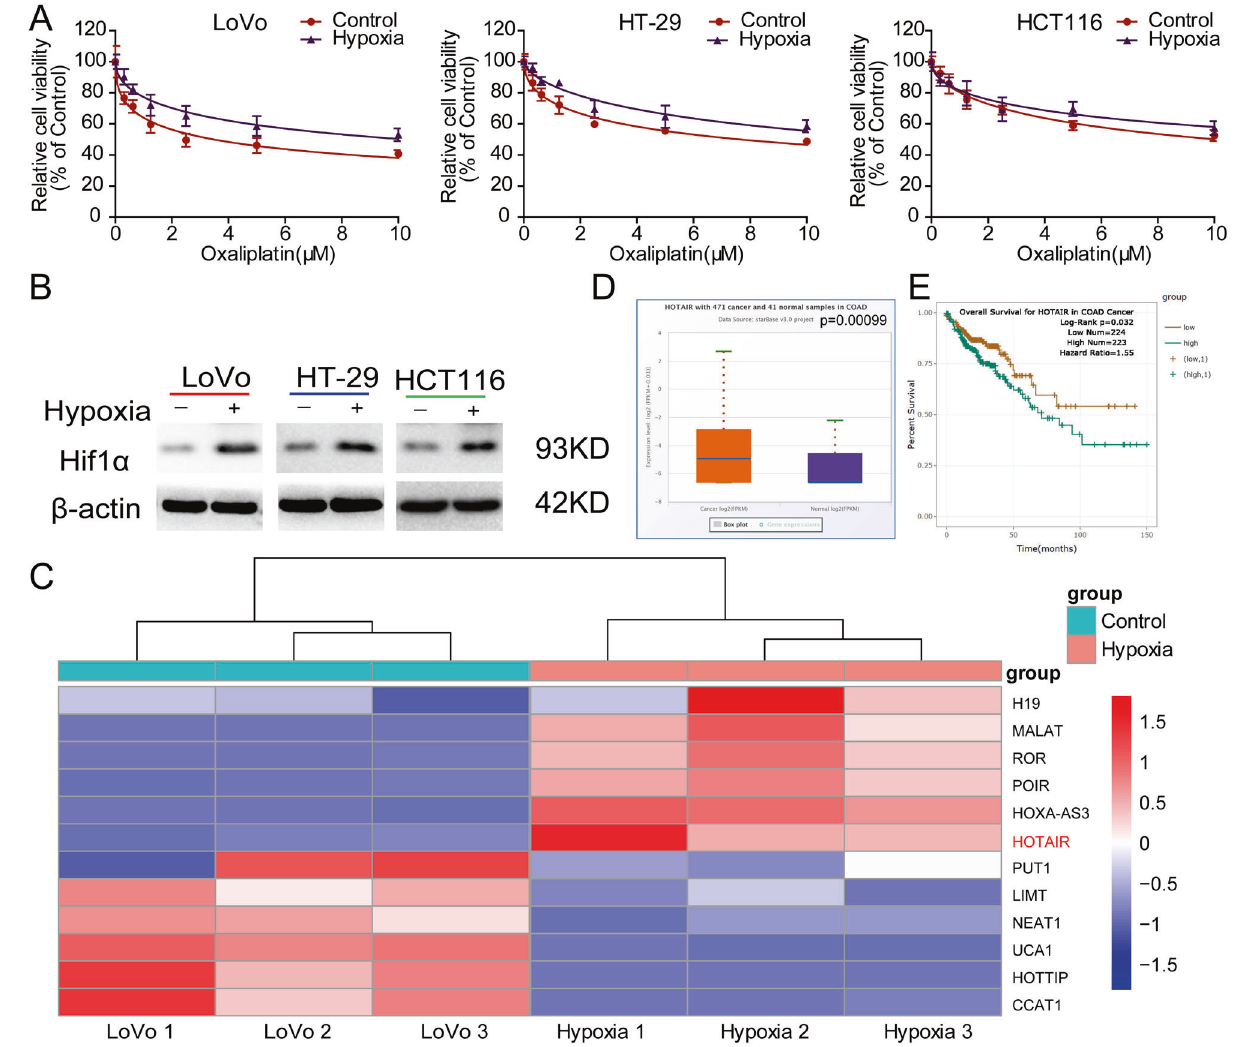
Fig. 1 Hypoxia-induced oxaliplatin chemoresistance and enhanced HOTAIR expression in CRC. A Dose-response inhibition of CRC cells (LoVo, HT-29, and HCT116) to oxaliplatin under normoxia or hypoxia conditions. The relative cell viability of CRC cells was detected by CCK-8 assay. B Comparison of HIF-1 α protein level in CRC cells between hypoxia and normal treatments. C Changes in lncRNA expressions under hypoxic treatment in LoVo cells. D Comparison of HOTAIR expression in CRC tissues to normal tissues. E Kaplan – Meier survival curve of COAD cancer patients with different HOTAIR expression (high vs